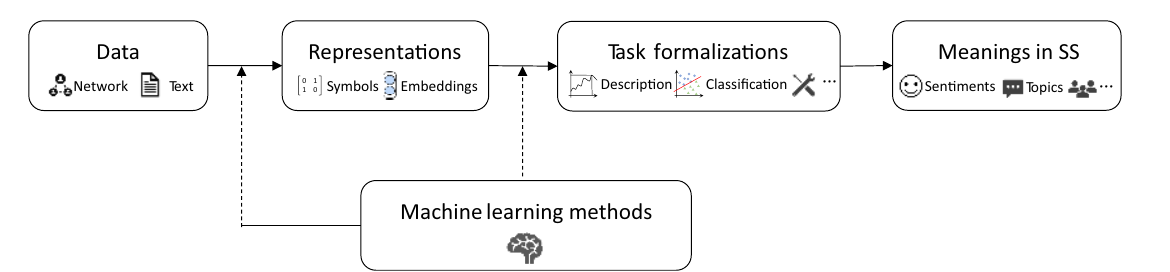
Fig. 1 Operational framework in CSS, where SS denotes social